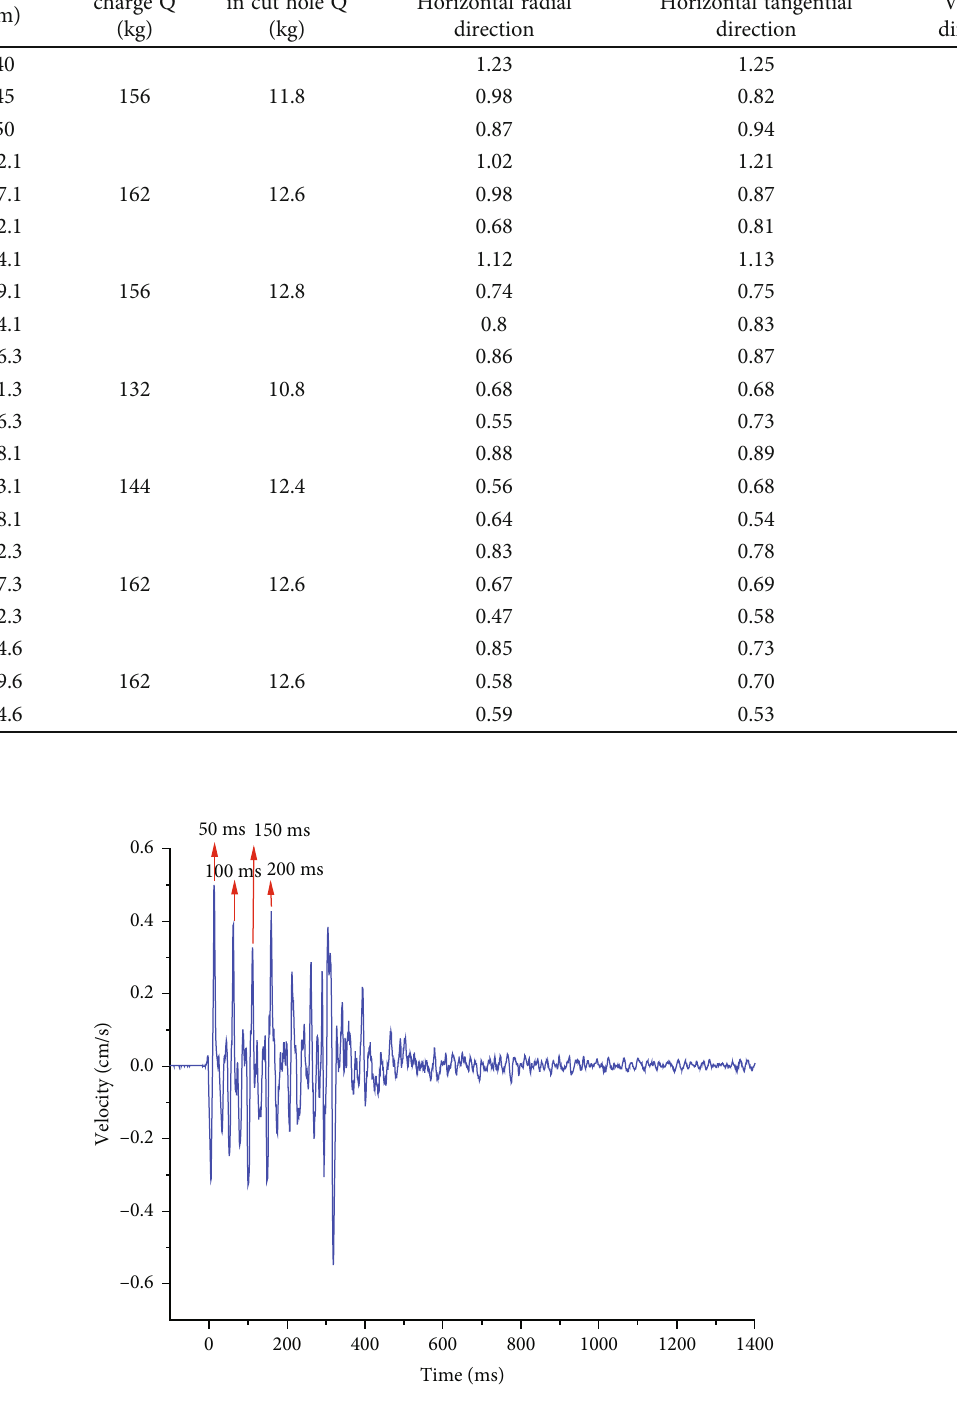
Figure 3: Typical waveform produced by three explosion